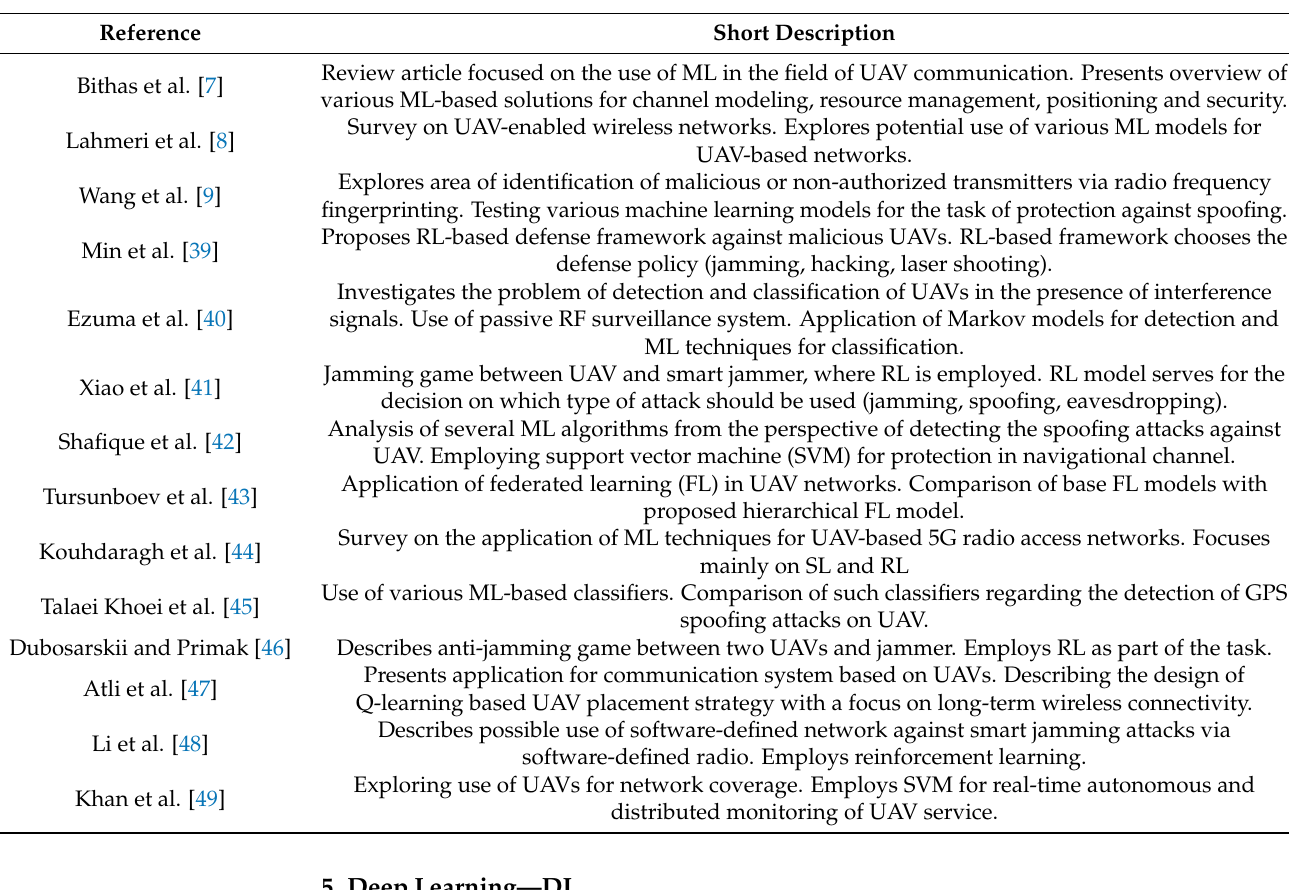
Table 3. Application of ML methods in UAV-related applications.